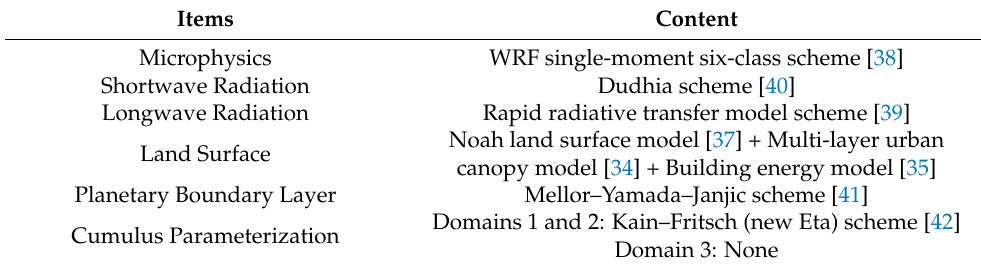
Table 3. Physical schemes for the WRF